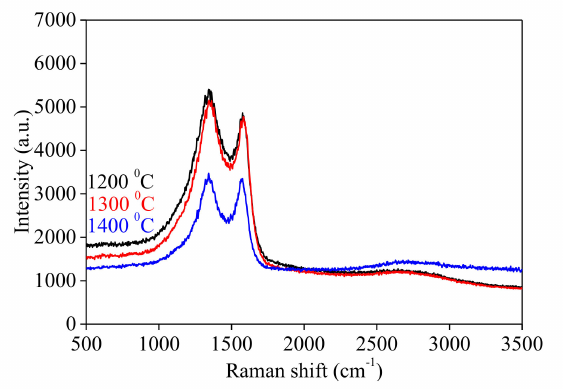
Figure 2. Raman spectrum of the samples carbonized at 1200 ◦ C (C-5), 1300 ◦ C (C-10), and 1400 ◦ C